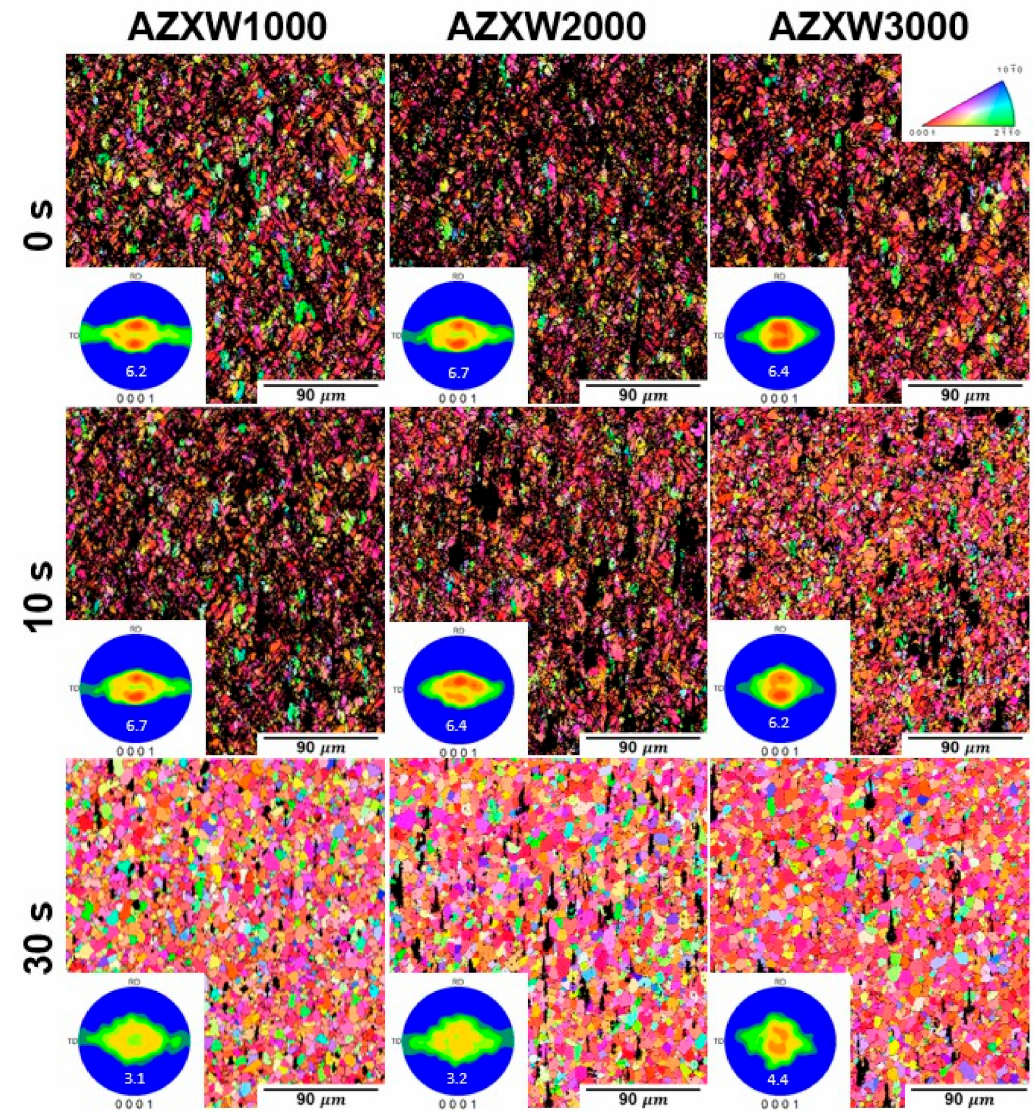
Figure 7. Inverse pole figure maps of the AZXW1000, 2000, and 3000 alloy sheets annealed for 0 s (as-rolled), 10 s, and 30